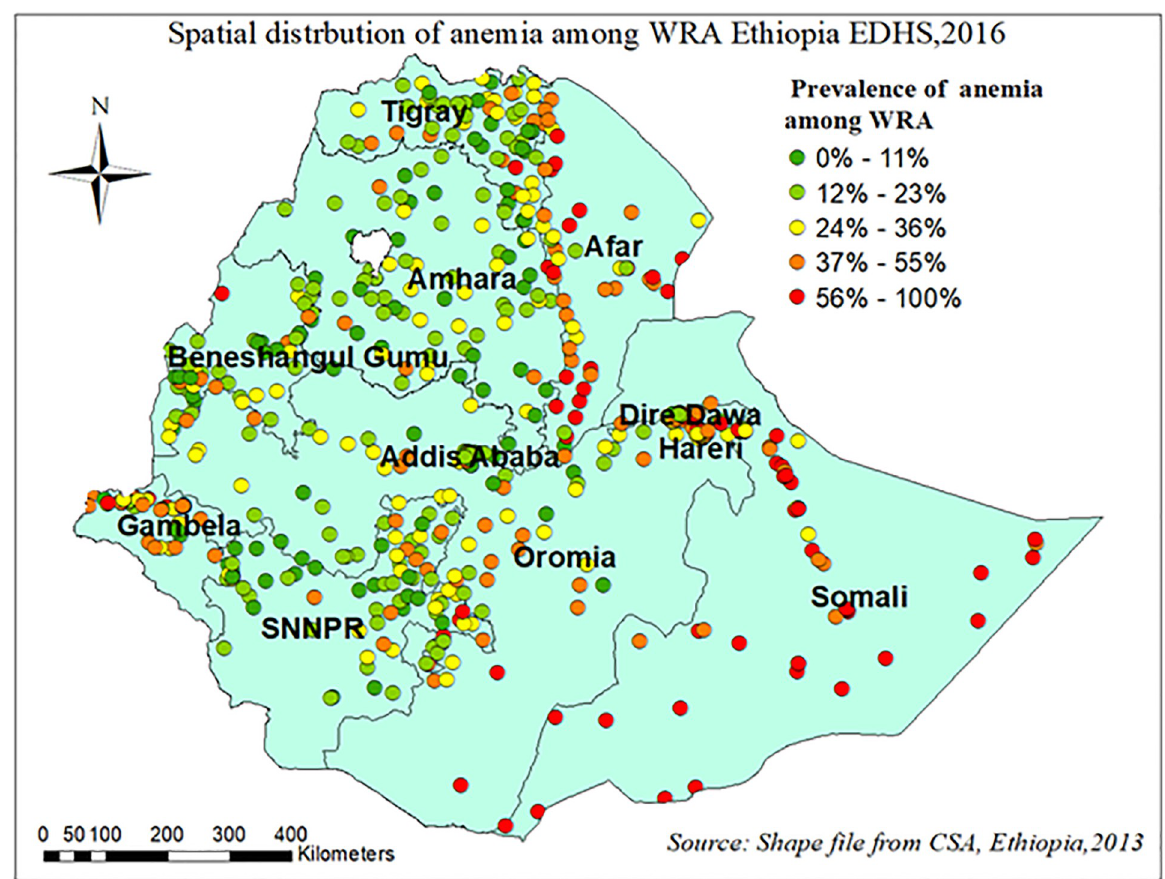
Fig 4. Spatial distribution of anemia among reproductive age women in Ethiopia, EDHS 2016. color indicates high-risk areas of predicted, and the green color indicates the predicted low- risk area of anemia among reproductive-age women. Based on this Somali, Afar and southern parts of the Oromia regions were predicted as riskier than other regions “Fig 9”. Factors affecting the spatial variation of anemia among reproductive-age women (modeling spatial relationships) Ordinary least square regression (OLS). As shown in Table 5 the OLS model explained about 35.5% (Adjusted R square = 0.355) of the spatial variation in anemia among reproduc- tive-age women. The coefficients represent the strength and the type of each explanatory vari- able and the anemia WRA Since the Koenker (BP) statistic was significant, we used the robust probability to determine the statistical significance of the coefficients and the coefficients of women who have formal education, women who use Pills/injectable/implant and women have more than one child within five years were statistically significant (p < 0.01). The Joint Wald statistic was statistically significant (p < 0.01) and this shows that the overall model was signifi- cant and also there is no multicollinearity between explanatory variables (Variance inflation factor (VIF) < 7.5). In addition, the Spatial Autocorrelation test (Moran’s I = 0.21, P < 0.01) revealed that residuals were spatially autocorrelated “Table 5”.